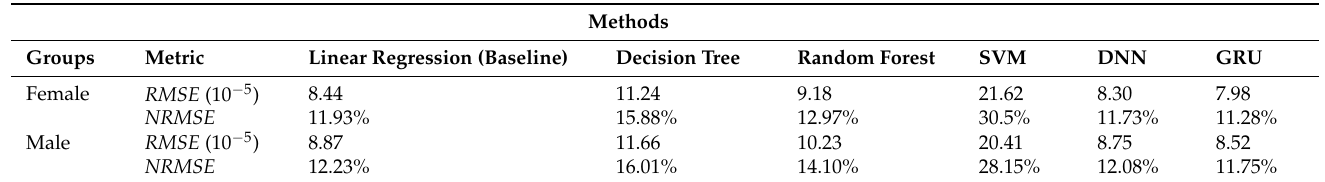
Table 3. Predictive performance of model comparison among baseline model, conventional machine learning methods and deep learning methods.